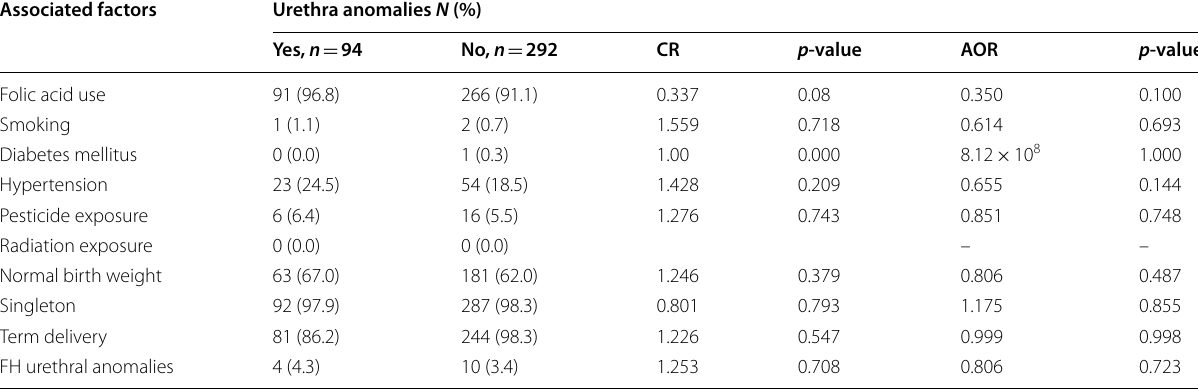
CR; crude ratio, AOR; adjusted odds ratio, FH; familial